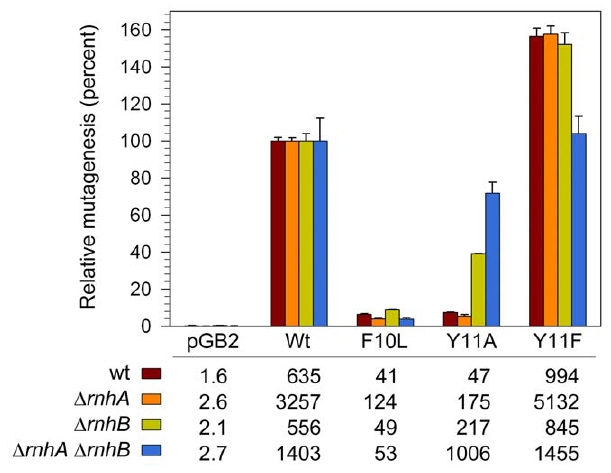
Figure 5. Effect of D rnhA and D rnhB on spontaneous mutagen- esis in recA730lexA (Def) D umuDC D dinB strains expressing pol V variants. Spontaneous mutagenesis was measured by assaying reversion of the hisG4 ochre allele (leading to histidine prototophy) as described in Materials and Methods . The average number of His + revertants per plate 6 standard error of the mean is indicated in the table. Since the extent of mutagenesis promoted by wild-type pol V differed in the various strains, we have expressed the level of mutagenesis promoted by the variants as a percentage of wild-type mutagenesis. As clearly observed, umuC _Y11A-dependent mutagenesis increased in the D rnhB strain and was further elevated in the D rnhA D rnhB double mutant. In contrast, umuC _F10L gave consistently low levels of mutagenesis in all strains, and umuC _Y11F higher than wild- type levels in all strains.